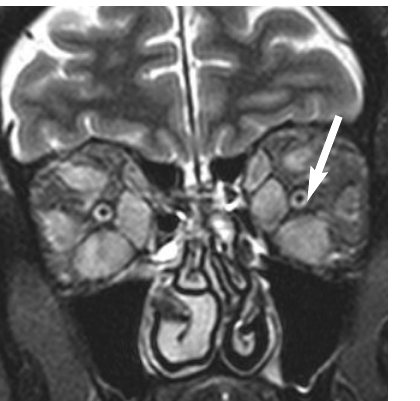
CoronalT1-w, gadolinium enhanced images with fat saturation. Coronal, strongT2-w image (TIRM) with fat a) Normal aspect of normally moderate enhancing extraocular muscles. suppression of the orbit. Voluminous thicken- b) Marked contrast-enhancement of enlarged orbital inferior and medial rectus muscles bilaterally. ing of all orbital muscles with oedematous changes, pathognomonic for active Graves’ orbitopathy.